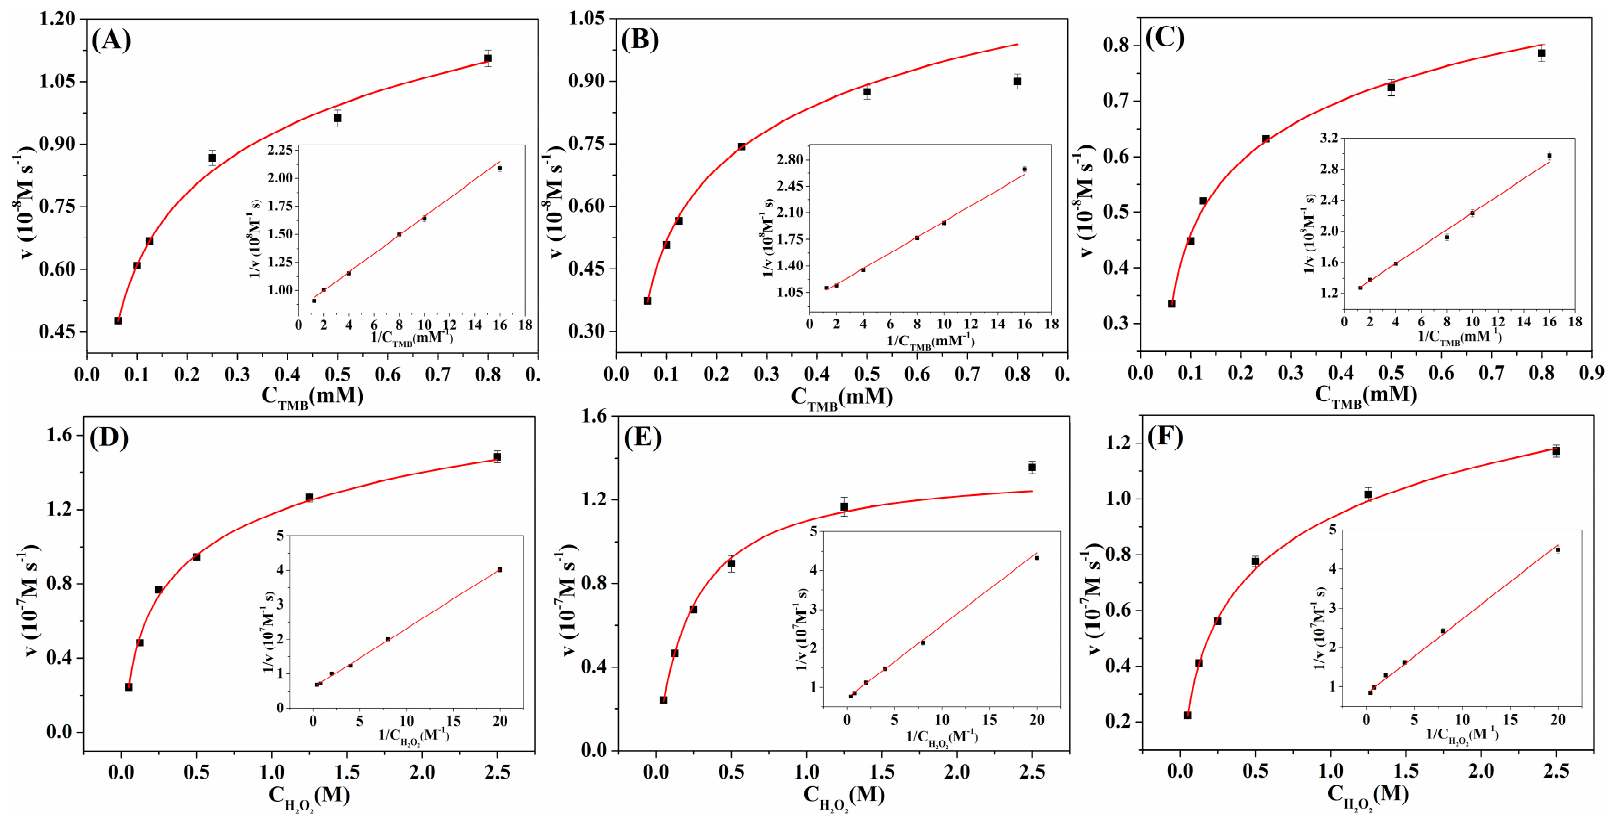
Figure 6. Steady-state kinetic analyses using the Michaelis–Menten model and Lineweaver–Burk model (insets) for PtNPs in the absence ( A , D ) and presence of 0.5 nM ( B , E ) and 2.0 nM ( C , F ) Ag + .